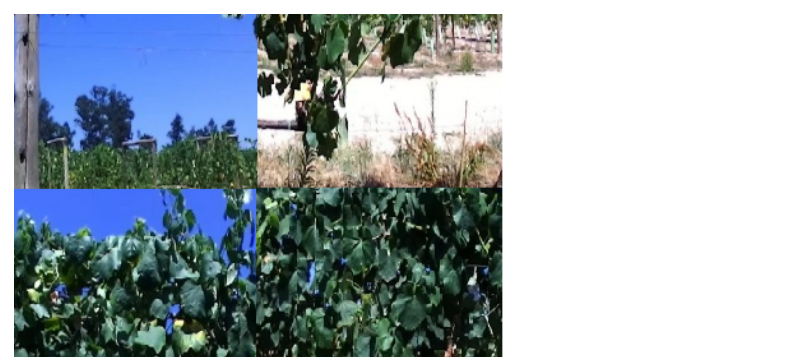
Figure 7. Classes representation, from top to bottom and from left to right: 0%, 33%, 66%, and 100%